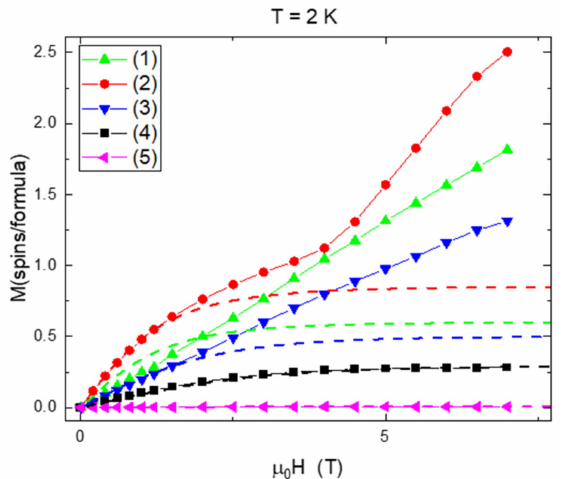
Figure 2. M(H) measurement for complexes ( 1 ), ( 2 ), ( 3 ), ( 4 ) and ( 5 ), in units of Bohr magnetons per molecule, obtained at T = 2 K. The dashed lines are results expected for non-interacting magnetic B / T and J = 1, 0.5, 1, 2 and 2.5 moments y ∝ B J ( x ) , B J the Brillouin function with x = gJ µ B k − 1 B for Zn, Cu, Ni, Fe and Mn, respectively. g is taken at g = 2.0 for all samples. Note that only the X = ( 4 ) sample is well-described by the dashed line. Samples ( 1 ), ( 2 ), ( 3 ) did not show a saturation of their magnetization, up to µ 0 H ∼ 7